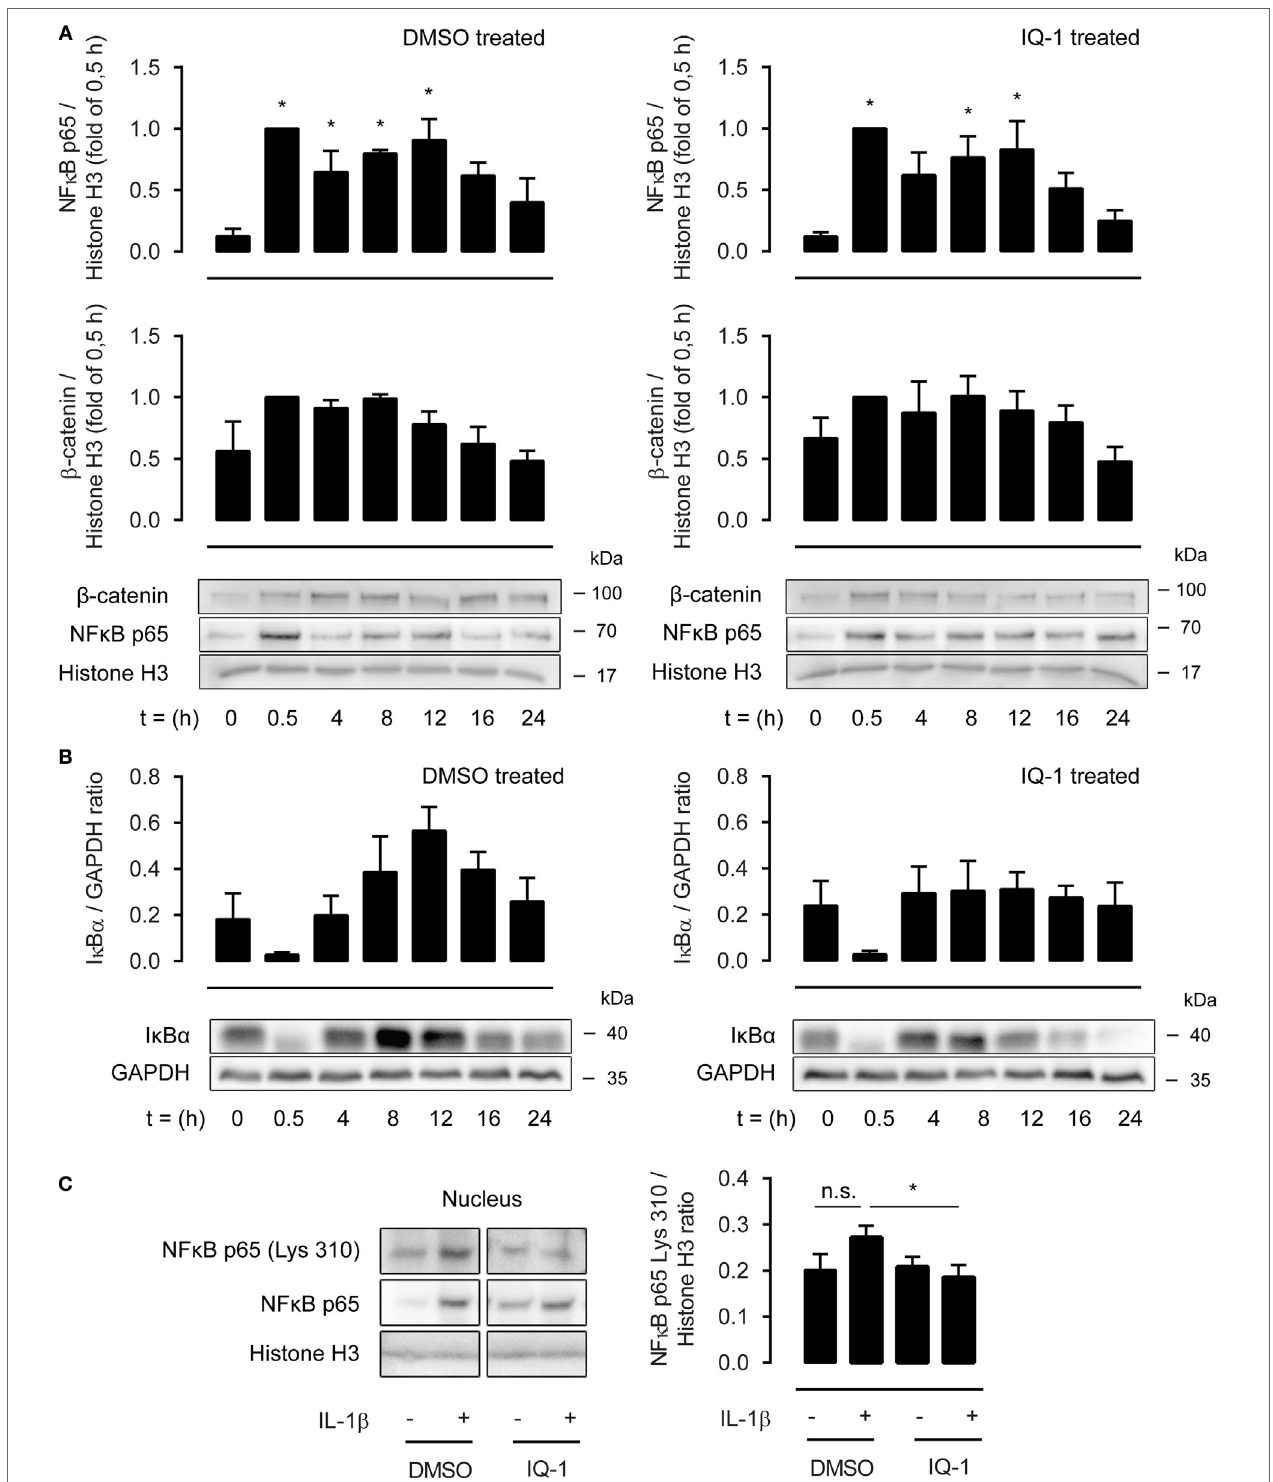
FigUre 5 | β -Catenin modulates p65 acetylation through p300. (a) Nuclear extracts were used to immunoblot nuclear factor- κ B (NF- κ B) p65 and β -catenin, normalized against Histone H3, at different time points following IL-1 β (1 ng/mL) stimulation, and pretreated for 30 min with DMSO (left panel) or IQ-1 (right panel). Data represent five independent experiments. (B) Cytosolic extracts were used to immunoblot I κ B- α and normalized against GAPDH, as in (a) . Data represent five independent experiments. (c) Nuclear extract immunoblot of acetylated p65 (lys 310), normalized against Histone H3. Airway smooth muscle cells were treated with IL-1 β (1 ng/mL) for 30 min with IQ-1 or DMSO as a vehicle control. Data represent six independent experiments. * vs. control.